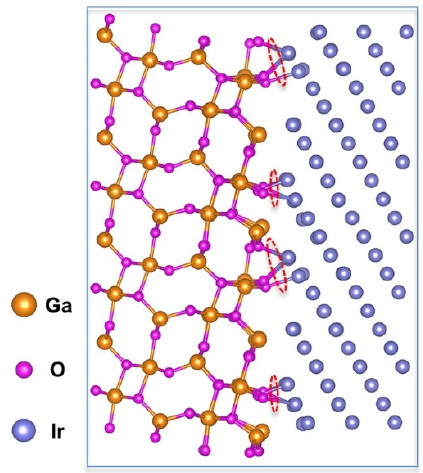
Figure 5. First-principles calculation of the β -Ga 2 O 3 /Ir interface. Models Ι – Ѵ are the possible atomic structure of the β -Ga 2 O 3 /Ir interface. The calculated binding energies (J/m 2 ) of five interface models are shown in the lower right of the figure.